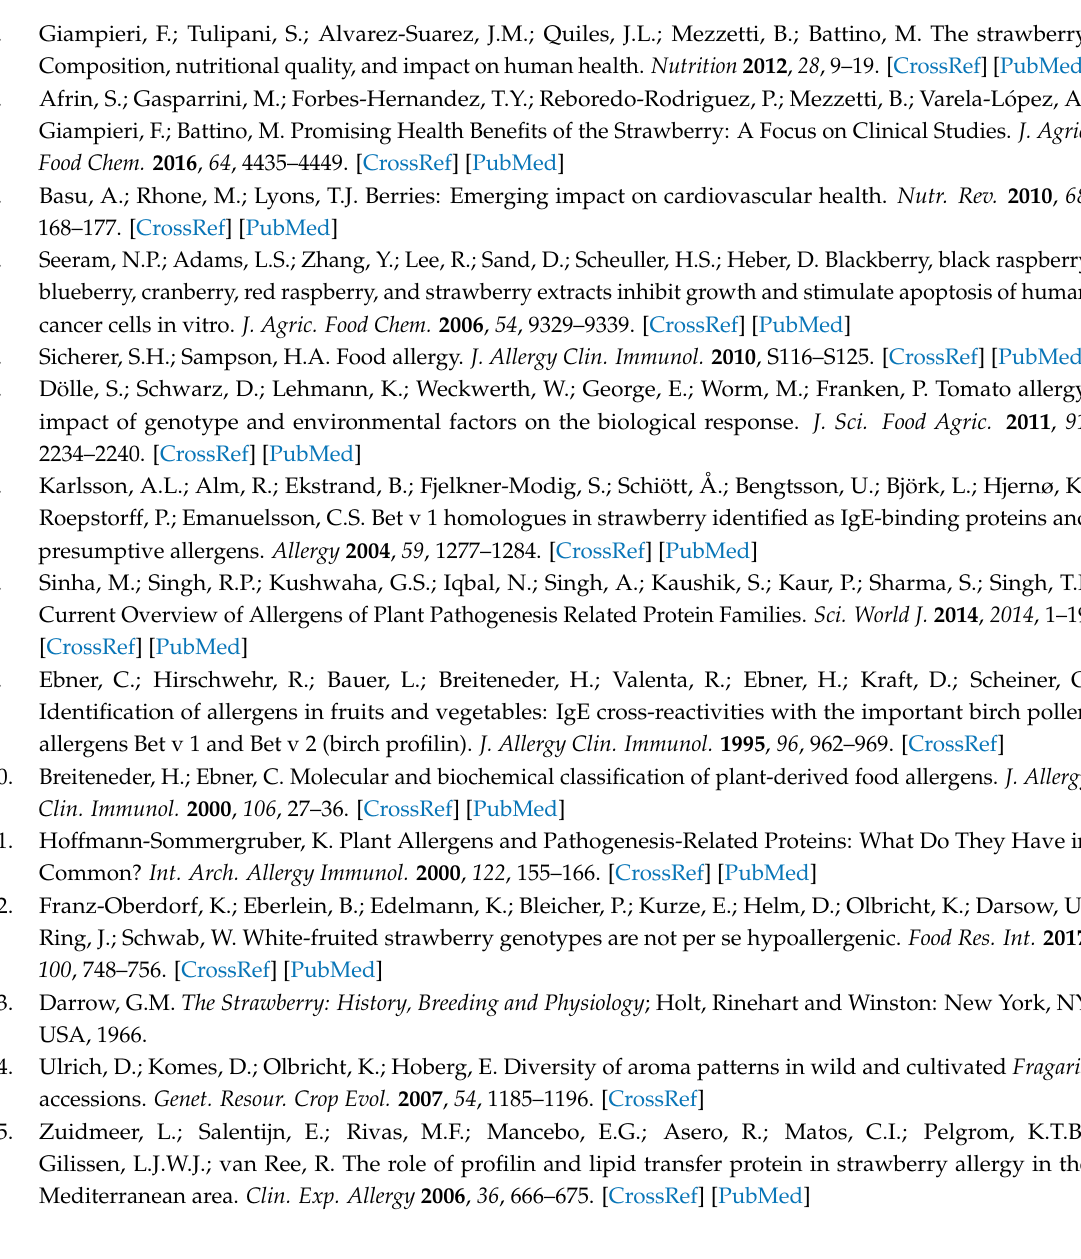
Strawberry cultivars, Table S2: Growing conditions for conventional and organic strawberry cv. Asia, Table S3: Temperature and relative humidity at the growing location Forl ì -Cesena in Italy for April and May in the years 2015 to